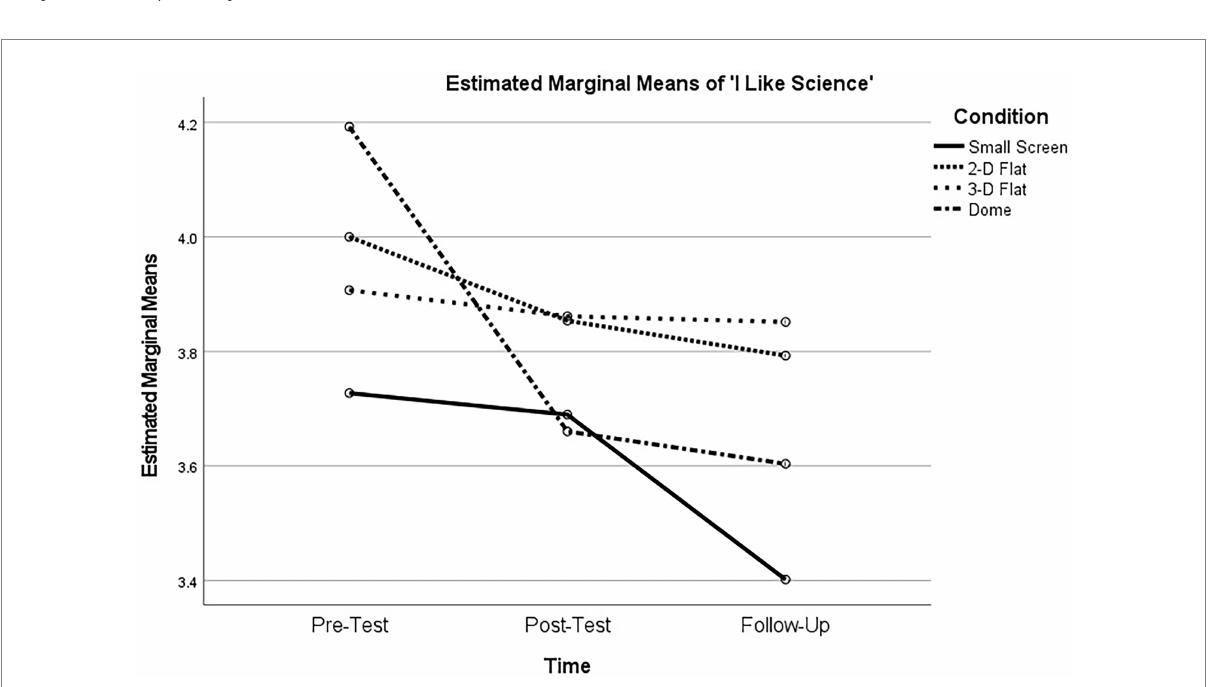
FIGURE 5 “I like science” question performance for the four groups.